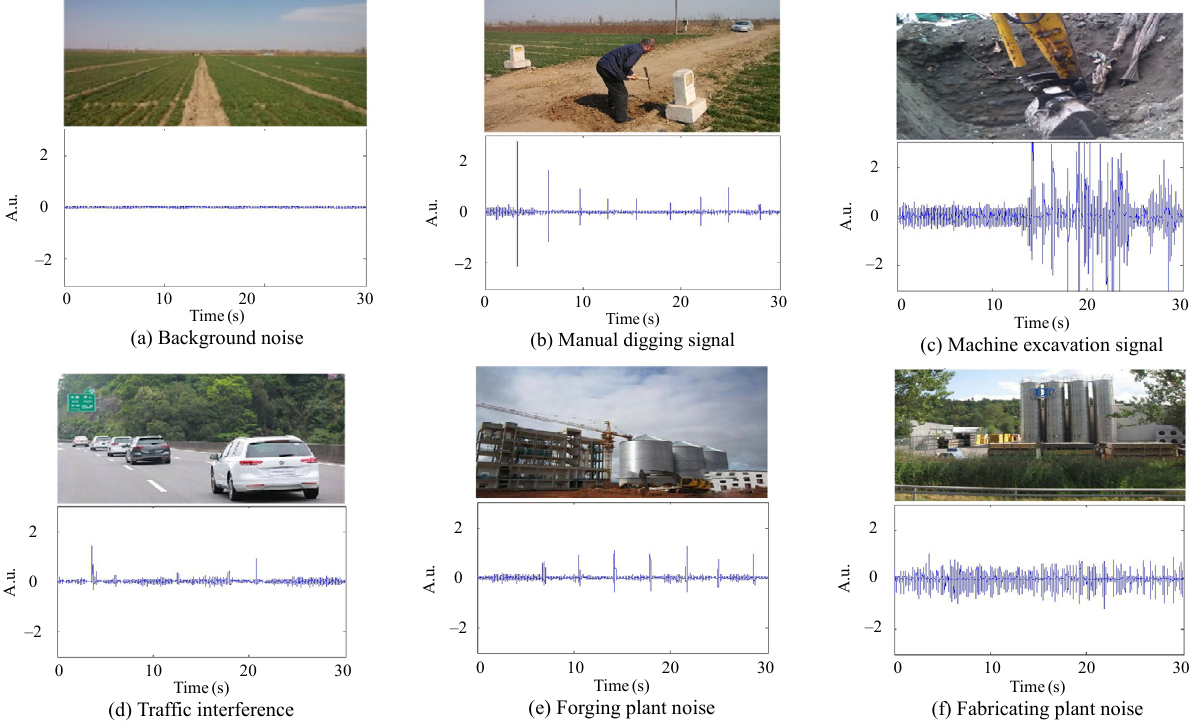
Fig. 32 Six signal samples for the five target